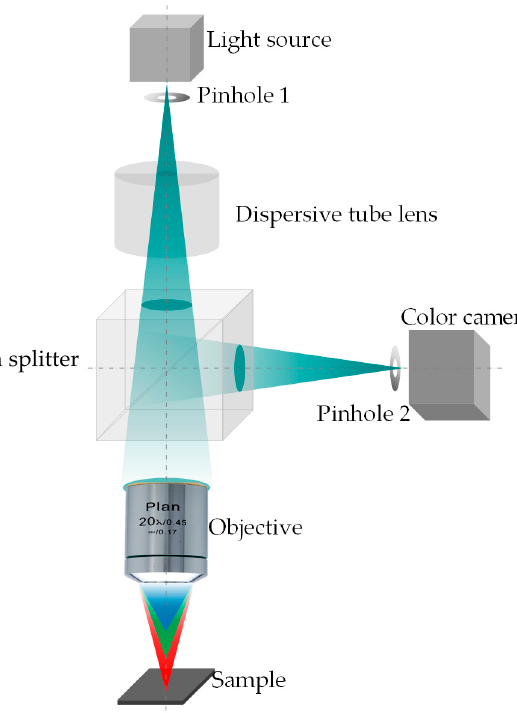
Figure 1. Principle of the chromatic confocal measurement method.